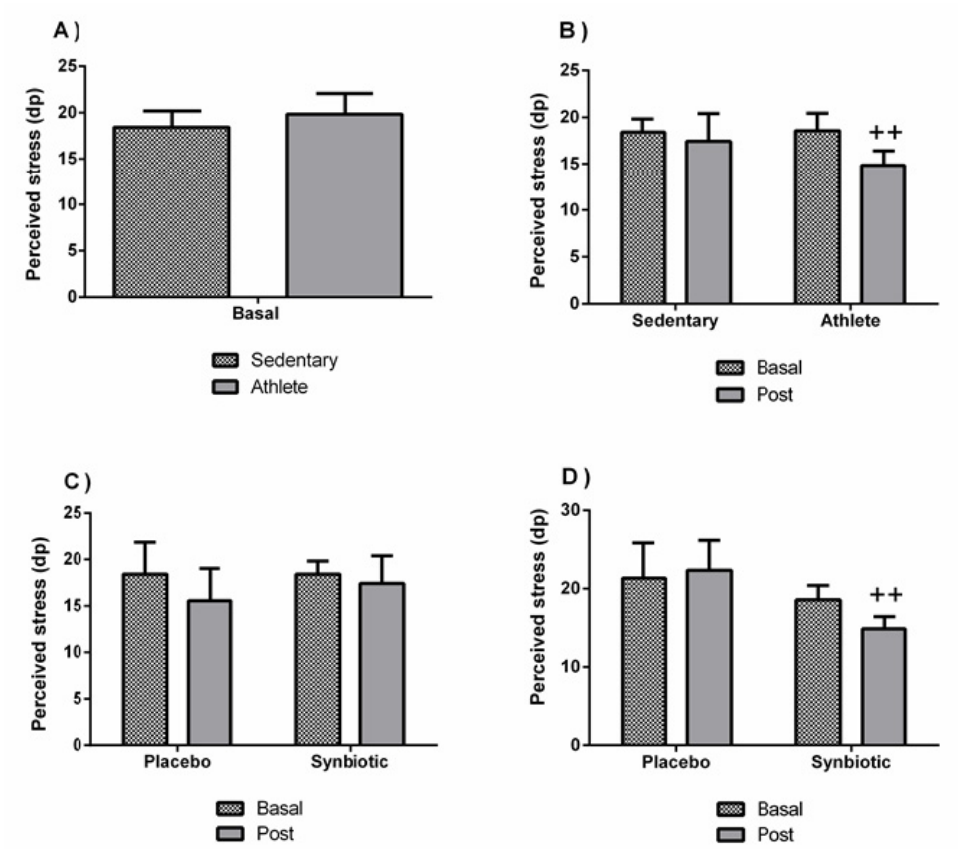
Figure 2. Effect of training and consumption of a synbiotic in this condition on perceived stress levels. ( A ) Perceived stress levels in sedentary men ( n = 14) and athletes ( n = 13); ( B ) Influence of training on the effects of the synbiotic on perceived stress levels ( n = 7 and n = 6 in sedentary and athlete groups, respectively); ( C ) Effect of the consumption of the synbiotic on perceived stress levels in sedentary individuals with respect to placebo ( n = 7) or with synbiotic ( n = 7); ( D ) Effect of the consumption of the synbiotic on perceived stress levels in athlete individuals with placebo ( n = 6) or with synbiotic ( n = 7). The determinations are expressed by the mean ± SD of each of the samples. ++ p < 0.01 with respect to the